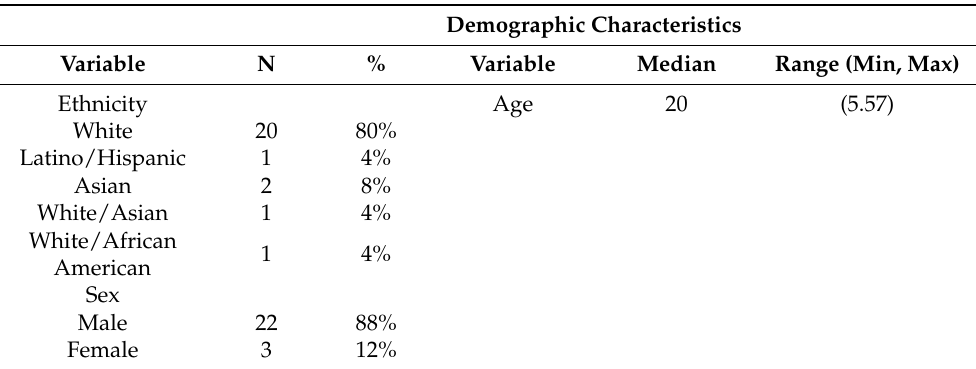
Table 1. Demographic characteristics of individuals with FXS ( n = 25).